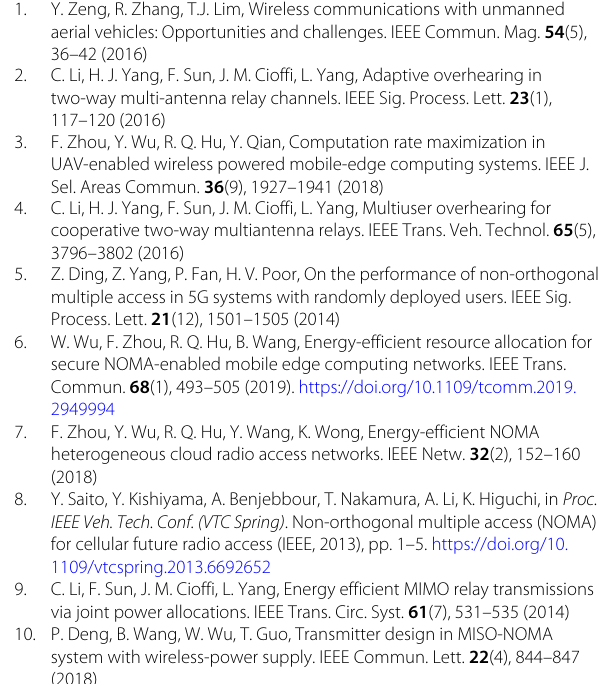
procedure, we can optimally solve the non-convex design problem by applying the technique of SDR. We also show that SDR here has no loss of optimality. Two suboptimal solutions with lower complexity than the optimal solution are also presented based on ZF and MRT. Experimental results show that the new approach of placement problem improves the security performance of UAV communica- tion